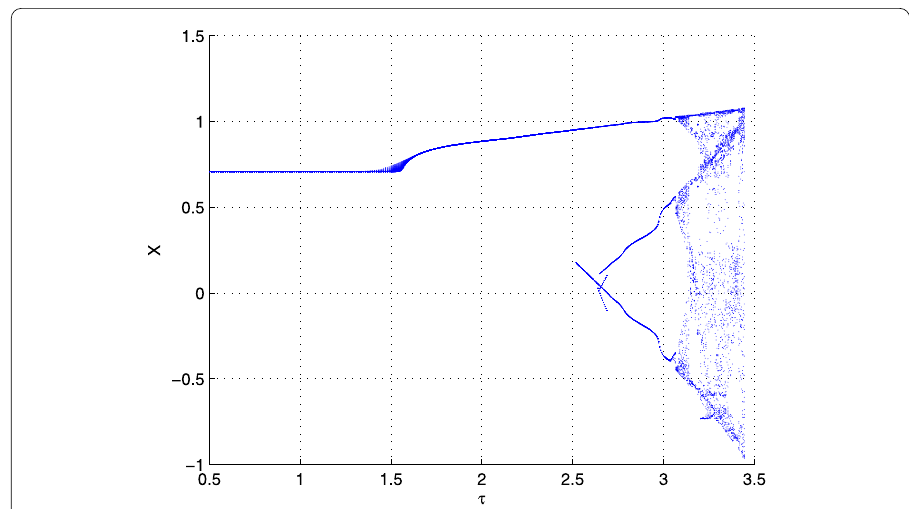
Figure 2 The bifurcation diagram of system (17) with the parameter γ = 0.5